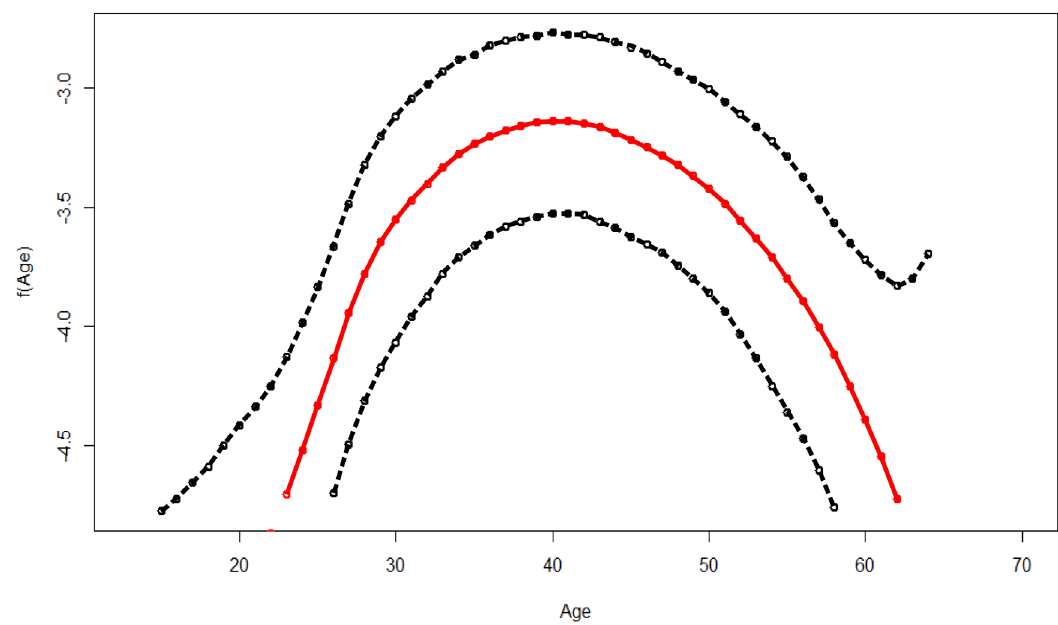
Figure 1. Estimated mean of the Nonlinear effect of age (in red) and the corresponding 95% credible interval (dotted black lines).